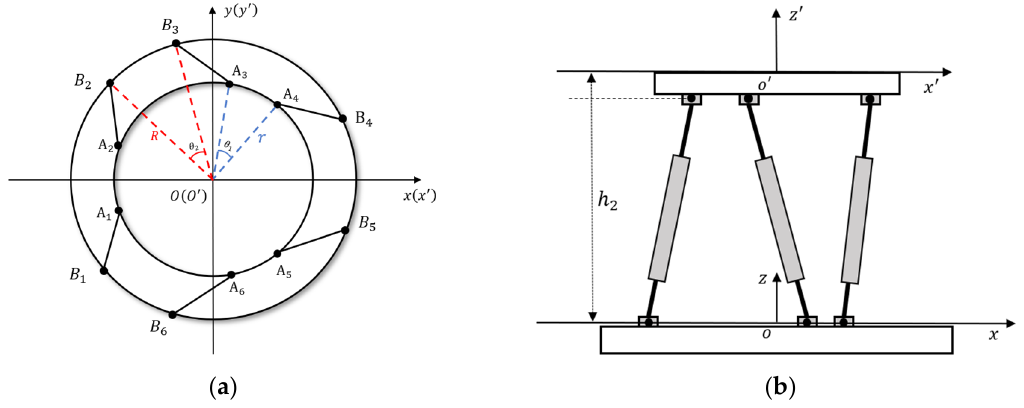
Figure 4. The geometry and parameters of the SGP. ( a ) The vertical view of the platform. ( b ) The main view of the platform. Table 1. The coordinates of the SGP hinge points for simulation (unit: centimeter).